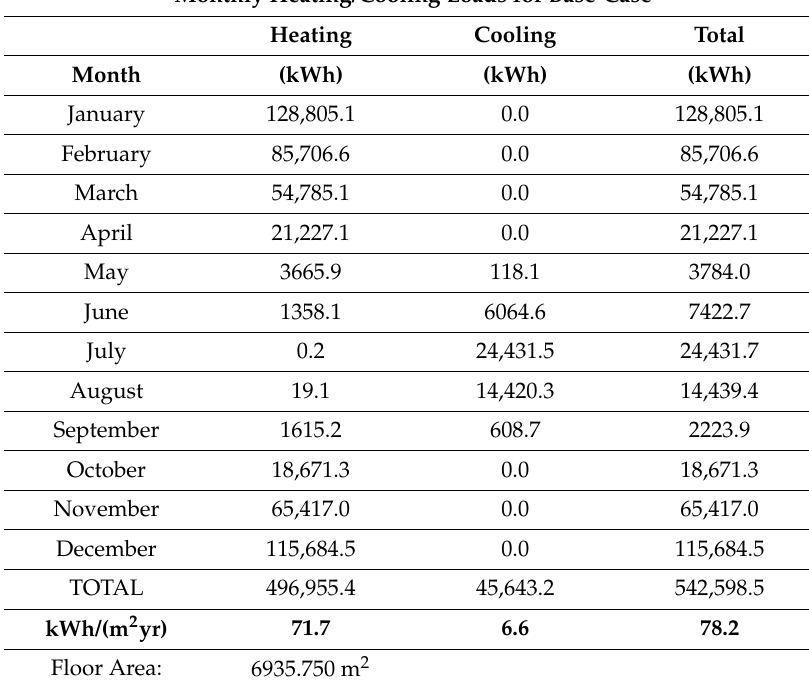
Table 6. Total energy demand of a building with the base-case energy